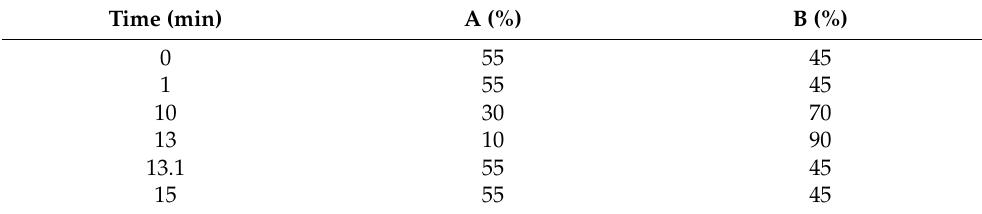
Table 1. The gradient elution